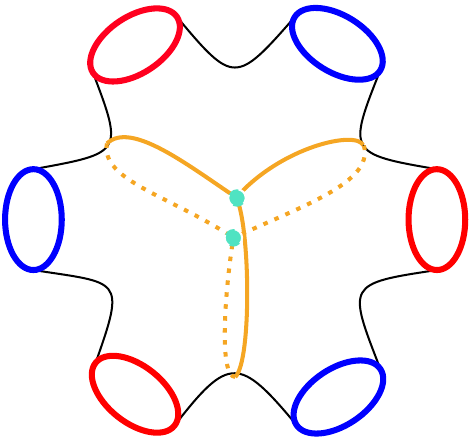
Figure 4 . Schematic picture of the replica geometry M 2 n ( n = 3 case). The n ( n = 3 ) red boundaries correspond to the boundaries of the universe A , i.e., ∂A . The others (blue) correspond to the boundaries of the universe B , i.e., ∂B . The cyan dots are the fixed points of this replica geometry. Upon taking the quotient of the geometry by the replica symmetry Z N , the orange lines become the branch